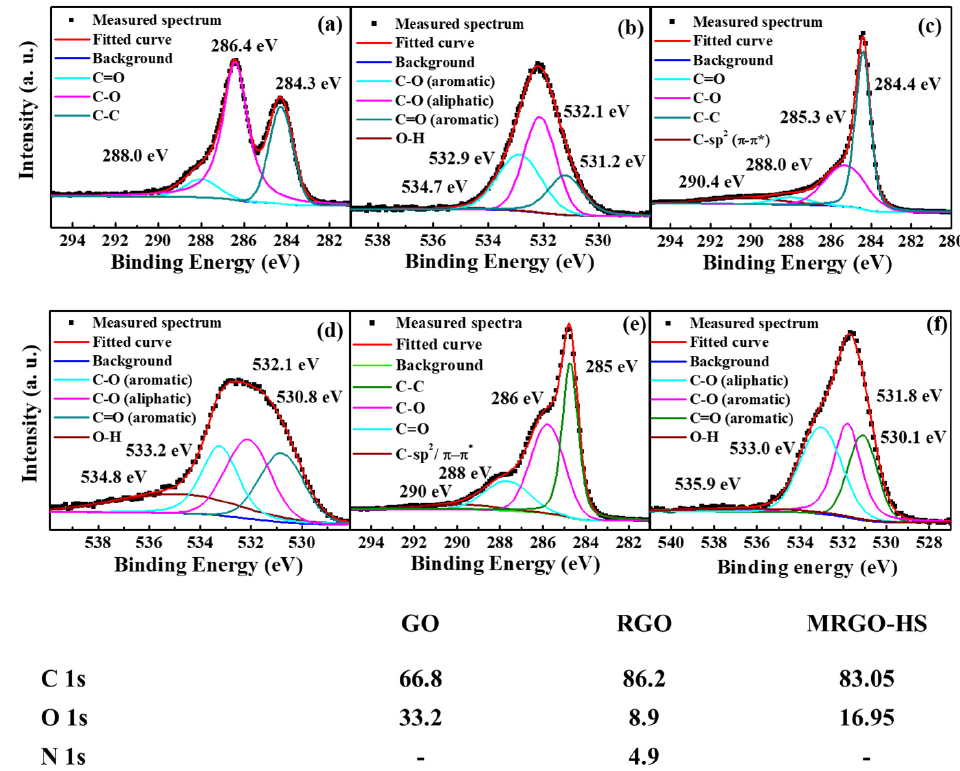
Figure 8. C 1s and O 1s core level X-ray photoemission spectra of the ( a , b ) GO, ( c , d ) RGO, and ( e , f ) MRGO-HS samples. The table below the spectra shows the atomic percentages of C, O, and N in GO, RGO, and MRGO-HS in the XPS analysis.